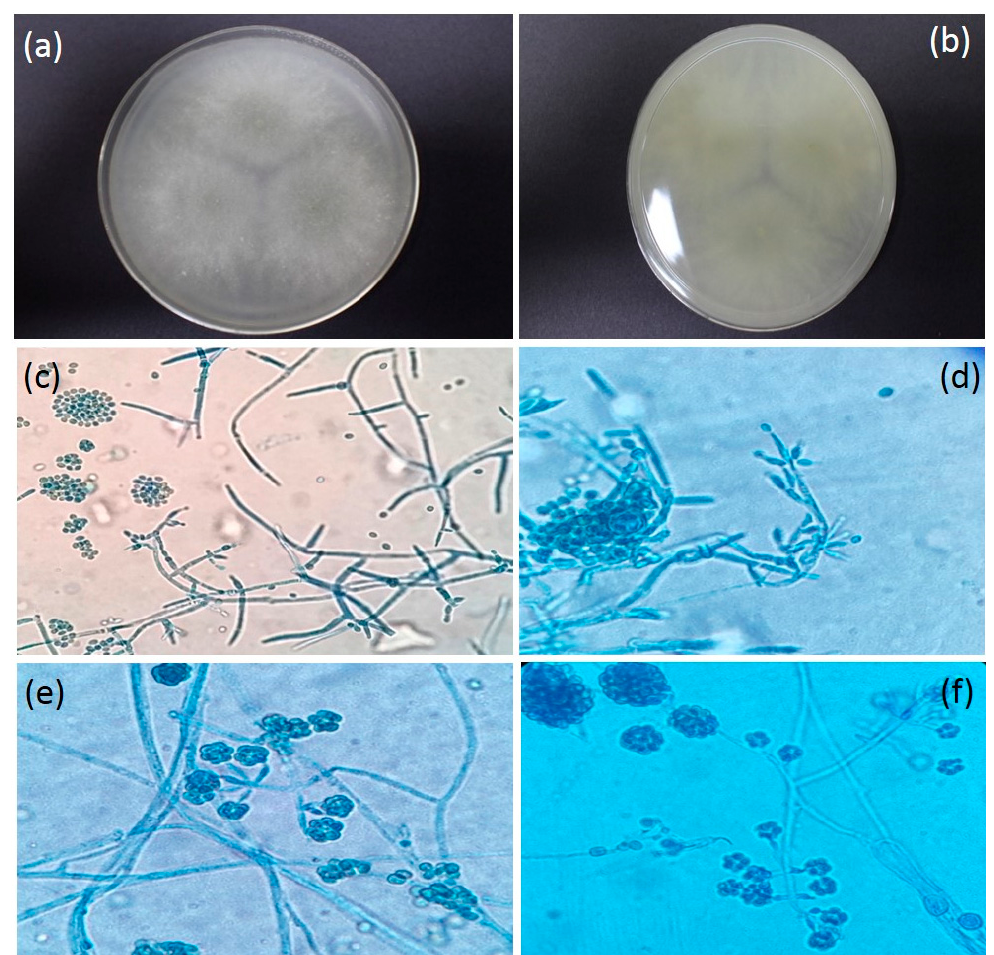
Figure 4. ( a ) Colony surface on PDA media (five days, 26.8 °C); ( b ) Reverse Colony on PDA media (five days, 26.8 °C); ( c ) Septate, Hyaline hyphae with Conidiophores branching at wide angles (near right angle) while some conidia clump together (Magnification 1000×); ( d ) Phialides in flask or ampule shape while some with single conidia are attached to the tips (Magnification 1000×); ( e ) Conidia clustered around tips of the phialides (Magnification 1000×); ( f ) Conidiophores branching at near right angles (Magnification 1000×).